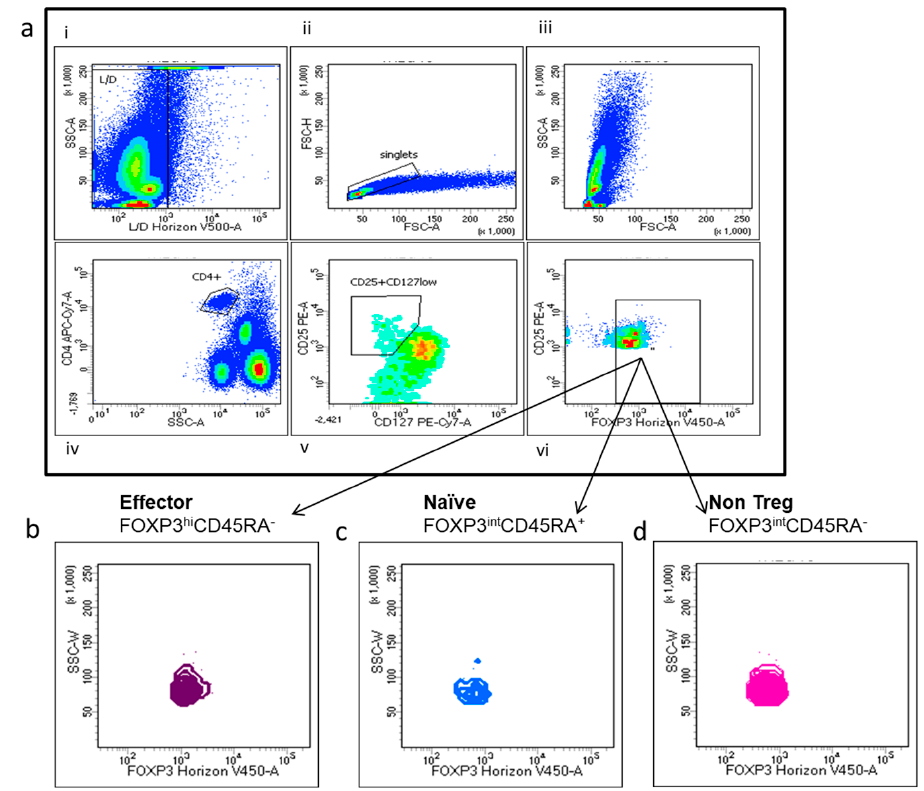
Figure 2. Multi-parametric Tregs and Tregs subtyping gate-strategy. ( a ) (i–vi) Representative fluorescence-activated cell sorting (FACS) plots: (i) dead cells identified as positive Live/Dead Horizon V450 and (ii) doublets cells were excluded; (iii) T lymphocytes were gated on the basis of their scatter parameters and (iv) CD4+ T cells were identified and analysed for CD25 and CD127 surface expression: (v) CD4+ T cells expressing high levels of CD25, negative or low expression of CD127, (vi) and FoxP3 positivity was considered as Treg cells (g–h) Treg subpopulation were identified according to Foxp3 level and CD45RA in eTregs (FoxP3hiCD45RA) ( b ), nTregs(FoxP3intCD45RA + ) cells ( c ) and non-Treg intCD45RA- cells ( d ).